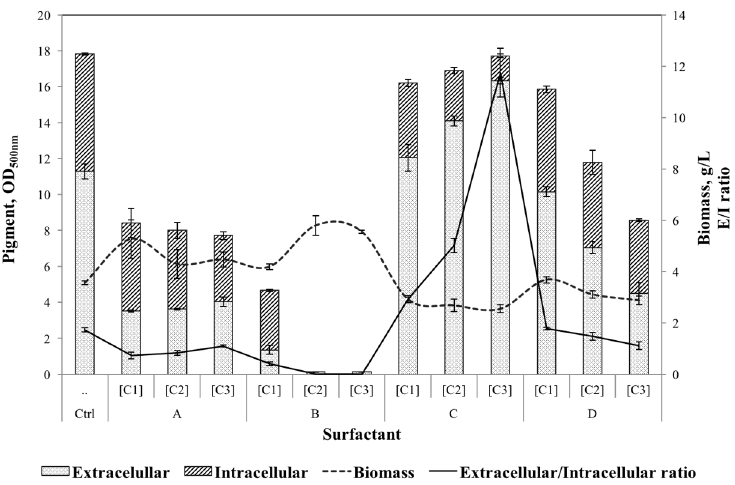
Figure 1. Screening of surfactants’ effect on extracellular and intracellular pigment yield, extracellular/intracellular pigment ratio and growth. Ctrl) Without surfactant, ( A ) polyethylene glycerol polymer PEG 8000; ( B ) Span 20; ( C ) Triton X-100 and ( D ) Tween 80. [Ci, g/L]: C1, 5; C2, 20; C3, 35.